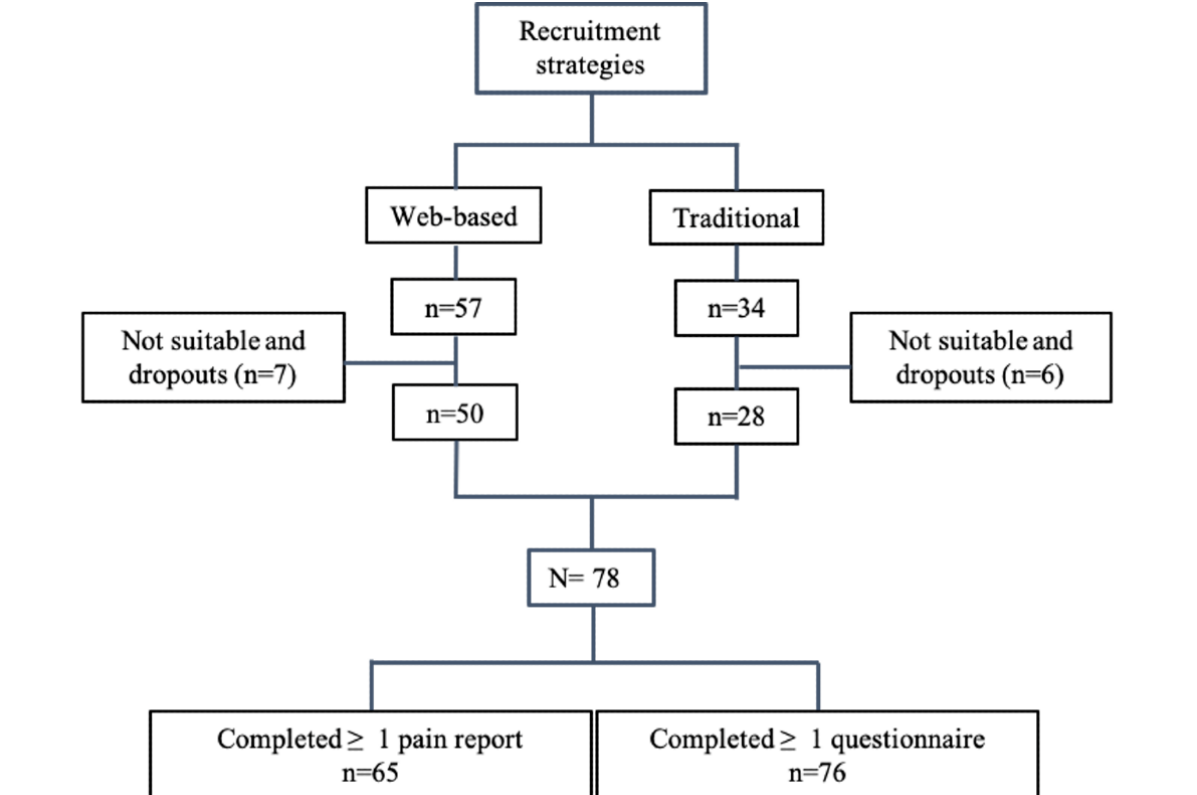
Figure 1. CONSORT (Consolidated Standards of Reporting Trials) flow diagram, showing the complete recruitment